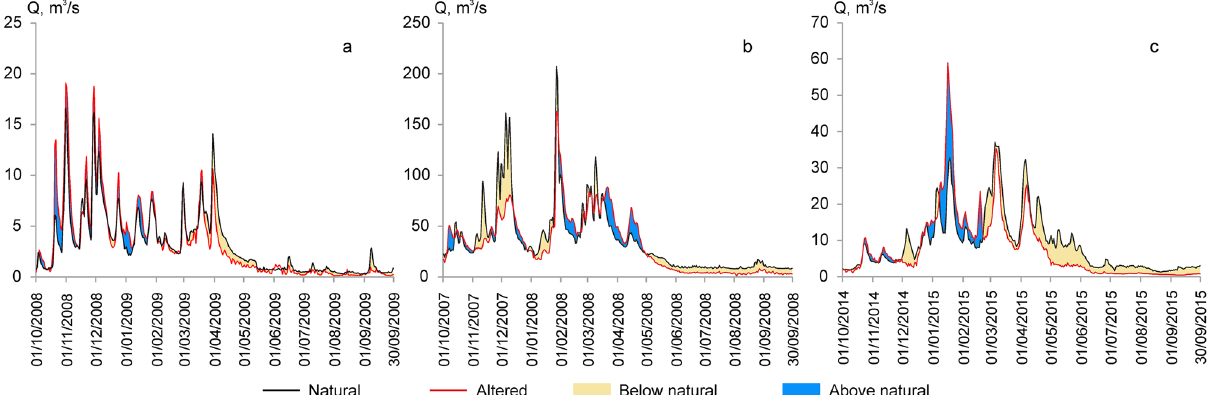
Figure 2. A comparison of hydrographs of natural and altered conditions during the dry years in the Bartuva River below Skuodas HPP ( a ), the Venta River below Kuodžiai HPP ( b ), and the Mūša River below Dvariukai HPP ( c ).